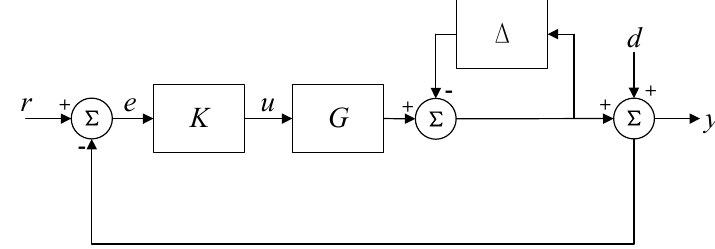
Figure 5. The control system of the studied EI with external disturbance and system uncertainties.